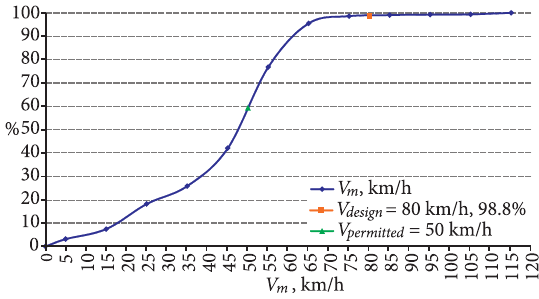
Fig. 2. Distribution of average momentary speed at regulation speed of 50 km/h